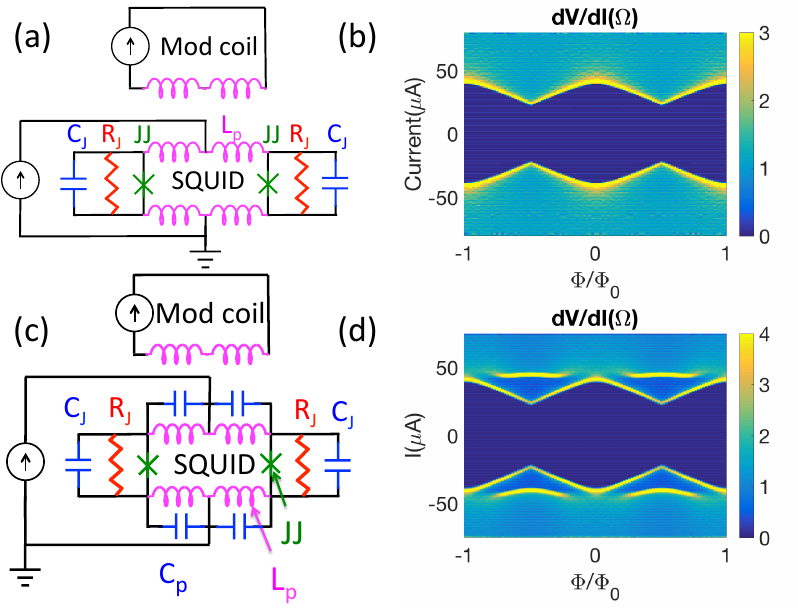
Figure 2. Adding a parasitic capacitance to an ideal Superconducting Quantum Interference Device (SQUID) produces a resonance. ( a ) Ideal SQUID schematic, and ( b ) calculated dV / dI characteristic for an ideal SQUID with no parasitic capacitance at T = 4.2 K. In this instance, the upper inductances L p = 30 pH, the lower inductances L p = 1 pH, the Josephson critical currents I 0 = 22 µ A, the shunt resistors R J = 2 Ω , and the junction capacitances C J = 10 fF. ( c ) Schematic with a parasitic capacitance, and ( d ) calculated dV / dI characteristic at T = 4.2 K. Here I 0 = 22 µ A, R s = 2 Ω , C j = 10 fF, upper L p = 30 pH, lower L p = 1 pH, upper C p = 10 pF, and lower C p = 1